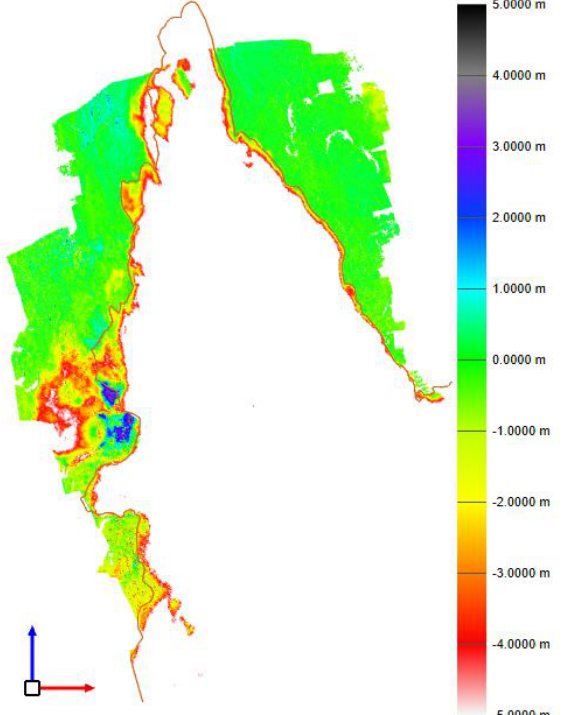
Figure 8. Height comparison map between 2014 DPC co- registered using ICPDPC method and 2016 DPC: focus on the area outside the glacier.